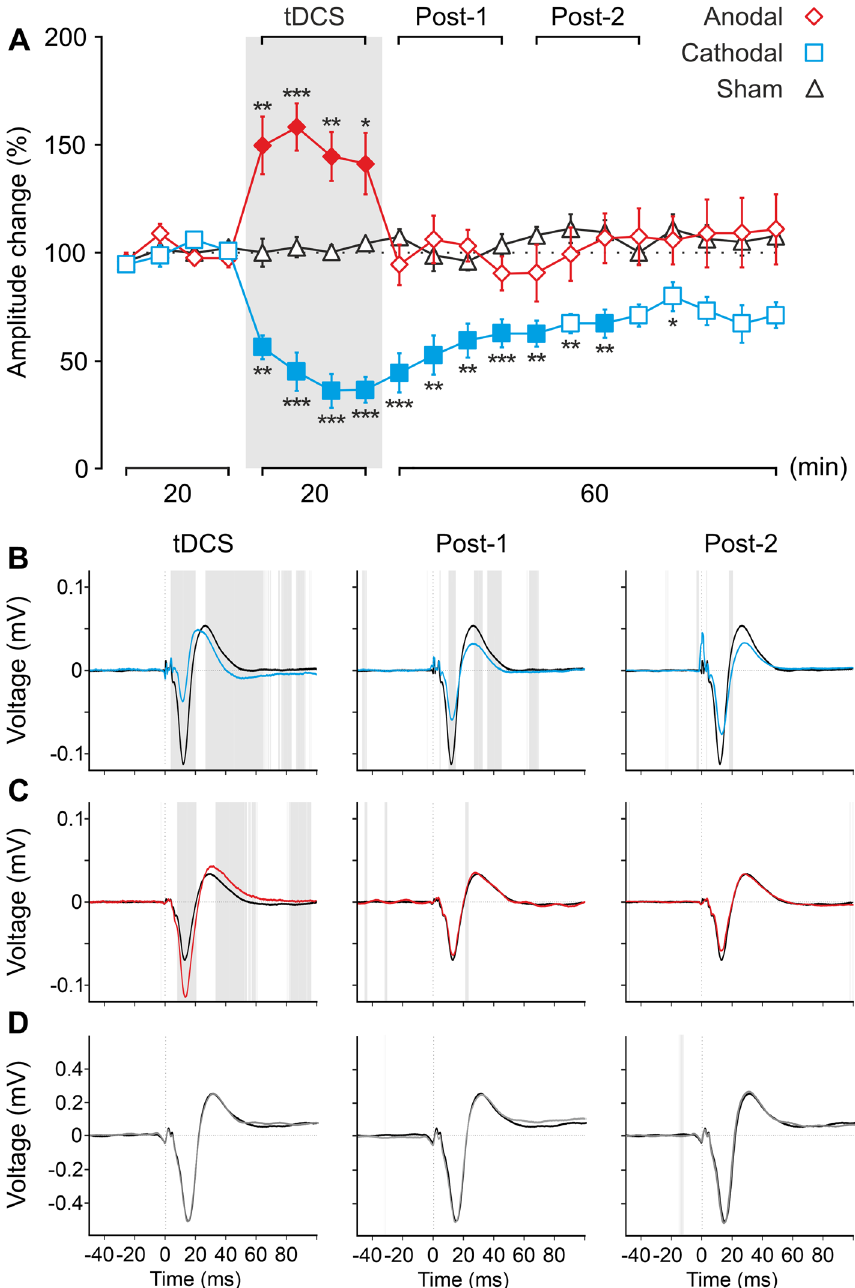
Figure 4. tDCS after effects over SEPs in S1 cortex. ( A ) Normalized amplitude change of N1 averaged every 5 min for 20 min of anodal (red diamonds), cathodal (blue squares) or sham (black triangles) tDCS. Two- way repeated-measures ANOVA, TIME: F 5.4,146.5 = 2.792, p = 0.016; tDCS POLARITY: F 2,27 = 20.895, p < 0.001, interaction TIME × tDCS POLARITY: F 10.9,146.5 = 8.967, p < 0.001. Filled symbols represent statistical differences with the last control period (n = 10 mice, p < 0.05, Bonferroni post hoc test). Asterisks mark statistical differences between the same temporal period for anodal or cathodal with sham tDCS (n = 10 animals, * p < 0.05; ** p < 0.01; *** p < 0.001, Bonferroni). ( B-D ) ERP analysis comparing all SEPs averaged 20 min before tDCS (black trace) with respect to averaged SEPs during 20 min of tDCS (first column), or averaged SEPs in the first 20 min after tDCS cessation (Post-1, second column) or the next 20 min (Post-2, third column) for cathodal (blue traces), anodal (red traces) or sham (grey traces) tDCS. Grey shadow represents statistical differences between points ( p < 0.05, paired